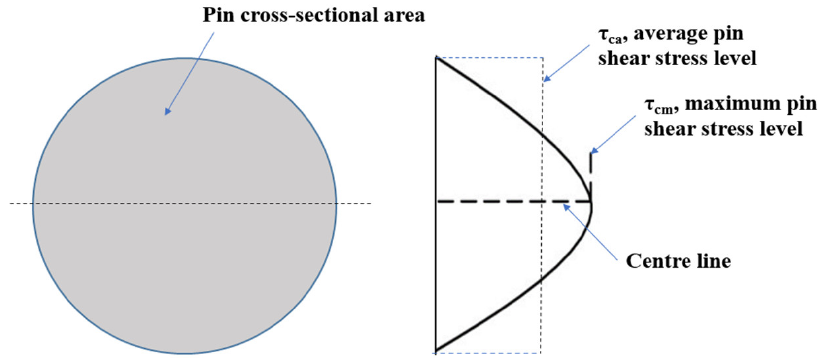
Figure 7. Shear stress distribution of the cylindrical pin section.